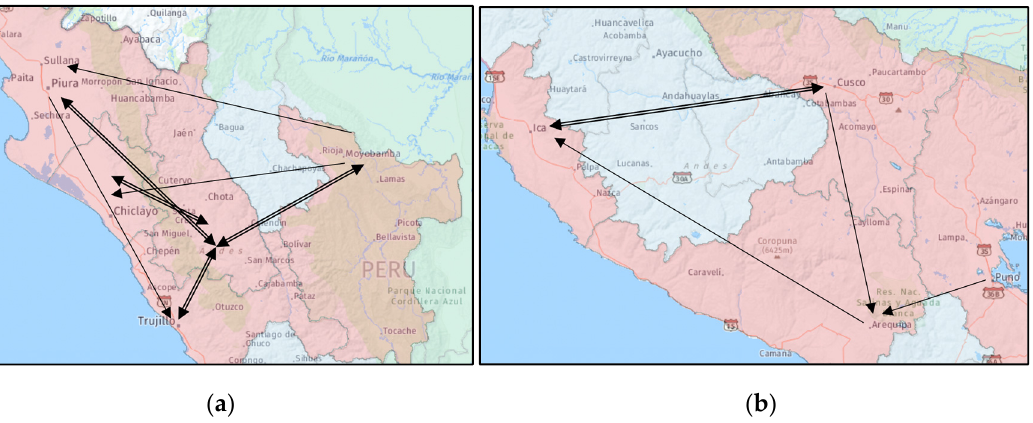
Figure 4. Origin-destination transaction networks for agricultural goods; ( a ) North network; ( b ) South-Central network.